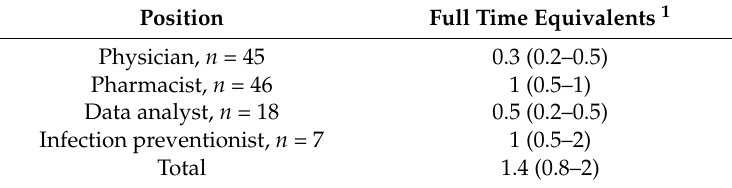
Table 2. Full time equivalents (FTEs) devoted to antimicrobial stewardship by